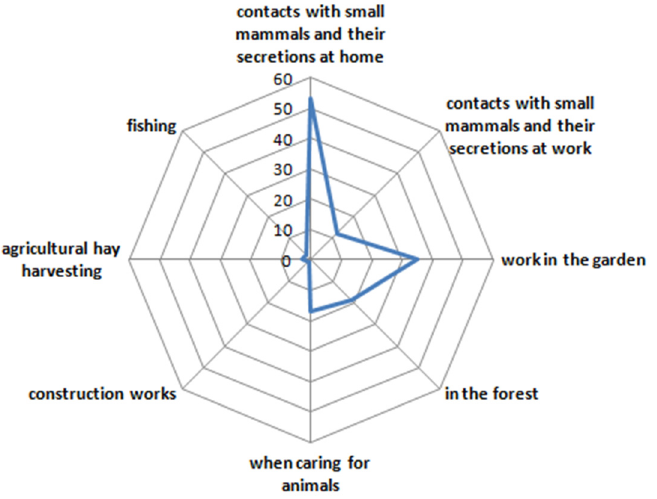
Figure 3. Ways of infection of the population with HFRS during the research period, 2021–2022.